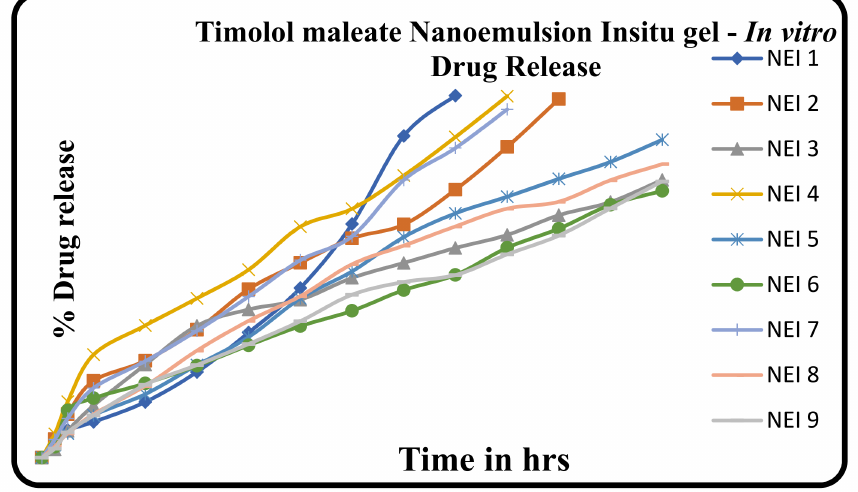
Figure 5. Trail batch. Comparative in vitro diffusion profile of trial